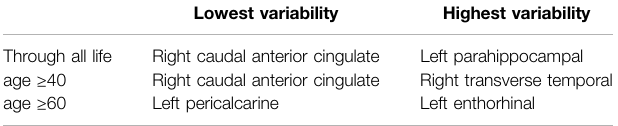
TABLE 4 | Variability of the cortical thickness through life. Lowest variability Highest variability